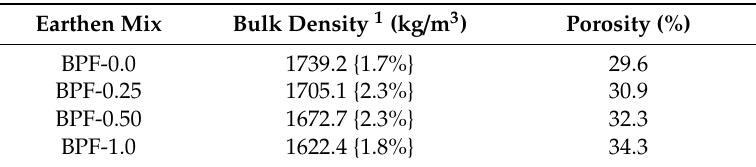
Table 5. Porosity values for each earthen mix.